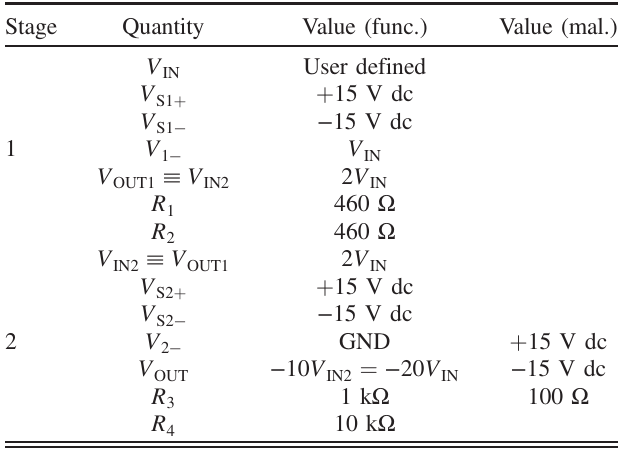
TABLE II. Nominal voltages and resistances in functioning (func.) and malfunctioning (mal.) versions of the circuit in Fig. 3, by stage. Characteristics of the malfunctioning circuit are listed only if they differ from the functioning